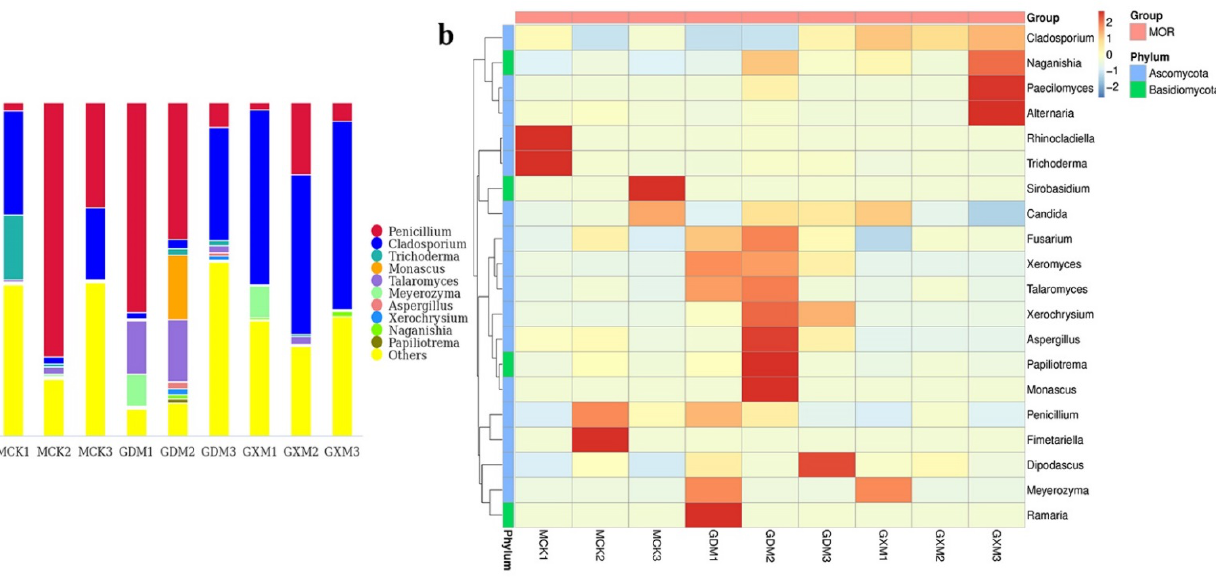
Figure 3. Composition analyses of the fungal microbiomes in the MOR samples. ( a ) Fungal compo- sition in MOR samples at genus level; ( b ) Heatmap of the top 20 genera in MOR samples. In the AOF group, Ascomycota was the most abundant phylum representing 14.81%– 81.85%, followed by Basidiomycota (0.36%–52.57%, Figure 4a). At the class level, Euroti- omycetes (0.57%–56.84%), Tremellomycetes (0.11%–51.81%), and Dothideomycetes (3.13%–46.37%) were prevalent (Figure 4b). Among the 39 orders detected, Eurotiales, Tremellales, and Capnodiales were dominant with the relative abundances of 0.41%– 56.29%, 0.09%–51.78%, and 3.11%–46.30%, respectively (Figure 4c). At the family level, the dominant fungi in samples ACK1 and HNA3 were Aspergillaceae (56.17%) and Rhyncho- gastremataceae (51.71%), respectively. Cladosporiaceae was dominant in the rest of the samples representing 5.71%–46.30% (Figure 4d). Penicillium (0.27%–56.06%), Papiliotrema (0.04%–51.71%), and Cladosporium (3.08%–44.41%) were dominant at the genus level (Fig- ure 5a). Candida was the subdominant genus in the ACK1 with the relative abundance of 11.95%, while it accounted for low levels in other samples (0.00–4.51%). A heatmap of the 20 most abundant genera is presented in Figure 5b. It is worth noting that a potential toxigenic fungus, namely, Trichoderma atroviride , was detected in all samples. Furthermore, another potential toxigenic fungus ( Fusarium equiseti ) was detected in four non-moldy samples (MCK1, MCK2, ACK1, and ACK3). The species and relative abundance of harmful fungi in each sample are shown in Supplemen- tary Tables S2.